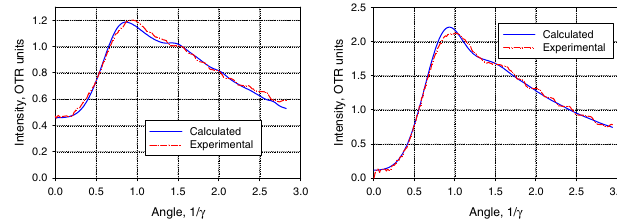
FIG. 14. (Color) Horizontal averaged line scans of ODTRI (left) and OTRI (right) shown in Fig. 13.